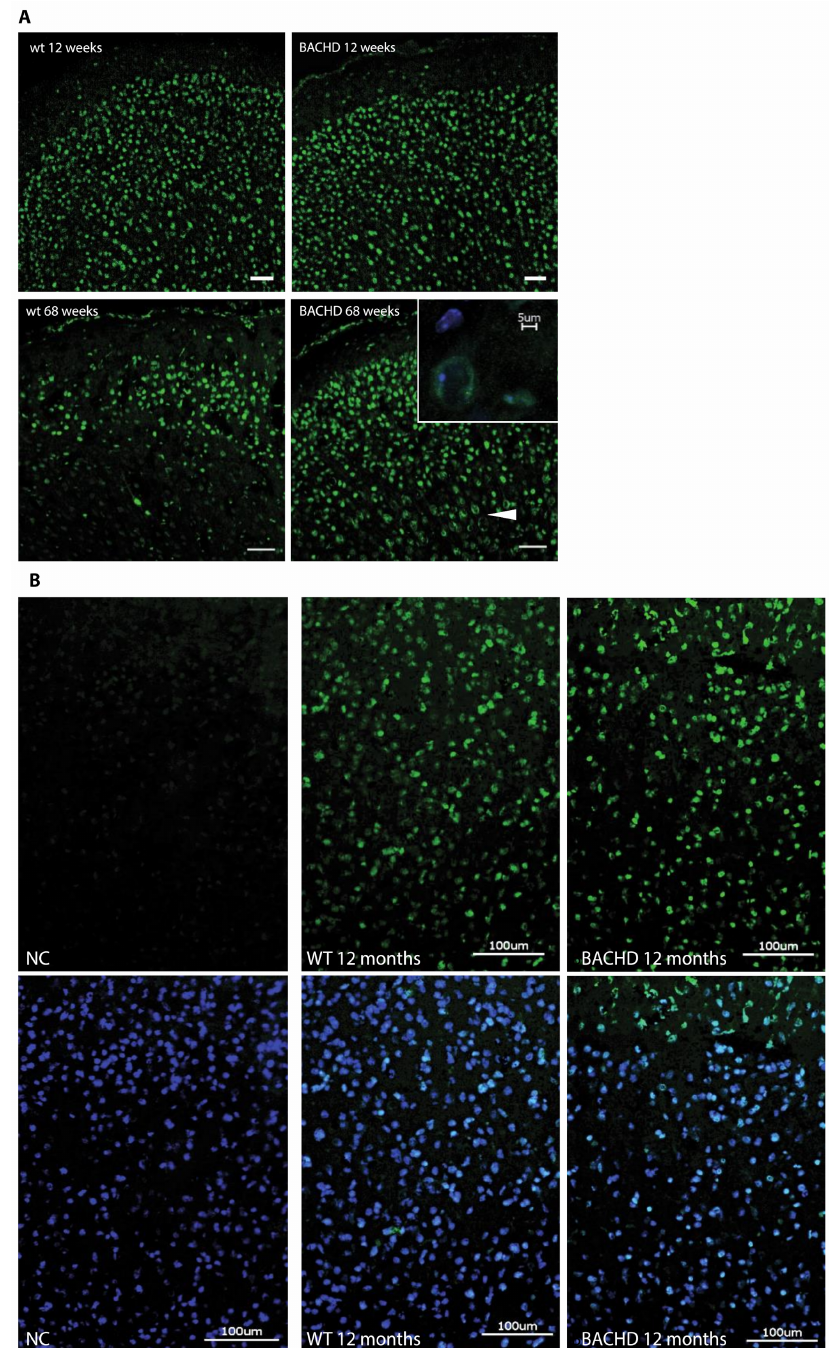
Figure 1. TG6 expression is prominent in the cerebral cortex of BACHD mice. ( A ) Detection of TG6 (green) in the cortices of wildtype (wt) and transgenic (tg) (BACHD) mice by immunofluorescent labeling at 12 and 68 weeks of age. Arrowhead points to distinct TG6 expression pattern in old tg mice. Inlay was taken from the region indicated by the arrowhead. Scale bars: 5, 50 µ m. ( B ) In situ assay of TG6 enzymatic activity on cryosections of 12 months old BACHD mice. TG6 activity (green) of wt (center panel) and tg (right panel) animals was determined by incorporation of biotinylated TG6-specific peptide. Nuclei were counterstained using DAPI. Negative controls (NC, left panel) were obtained emitting CaCl 2 in the incubation buffer. Scale bar: 100 µ